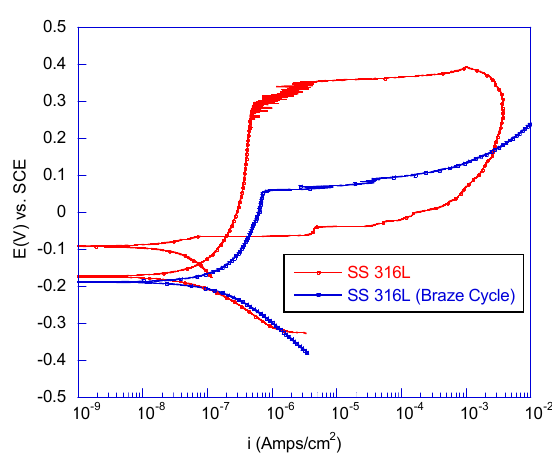
Figure 6. Potentiodynamic polarization scans conducted on 316L stainless steel subjected to a thermal brazing cycle (blue curve) compared to unfired 316L (red curve). Testing was conducted in 0.6 M NaCl with a scan rate 0.166 mV/s.